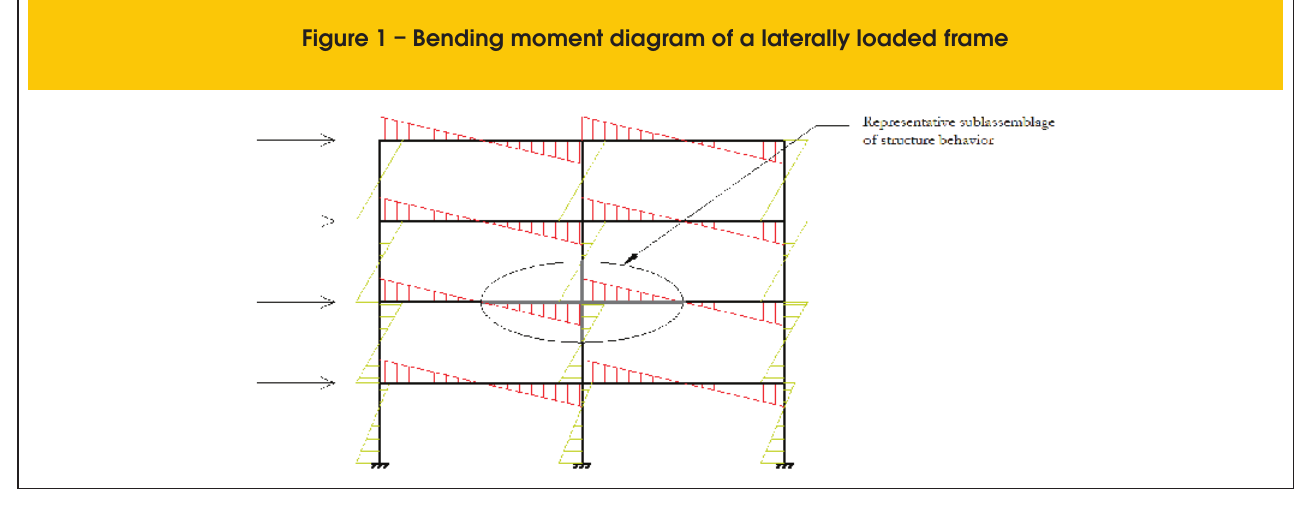
Figure 2 – Building subjected to lateral loads with all different joint